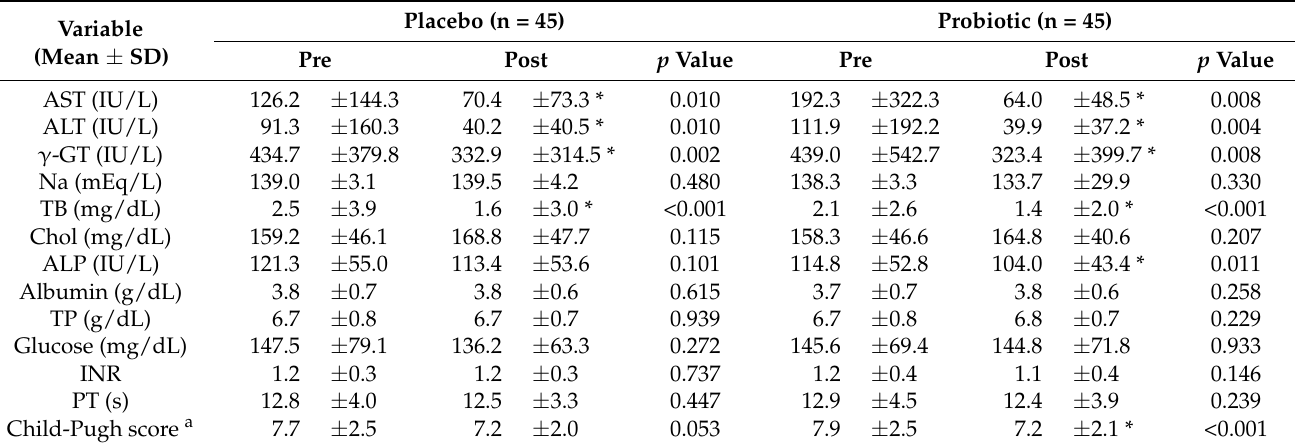
Table 2. Patients’ clinical characteristics and changes in liver function tests.